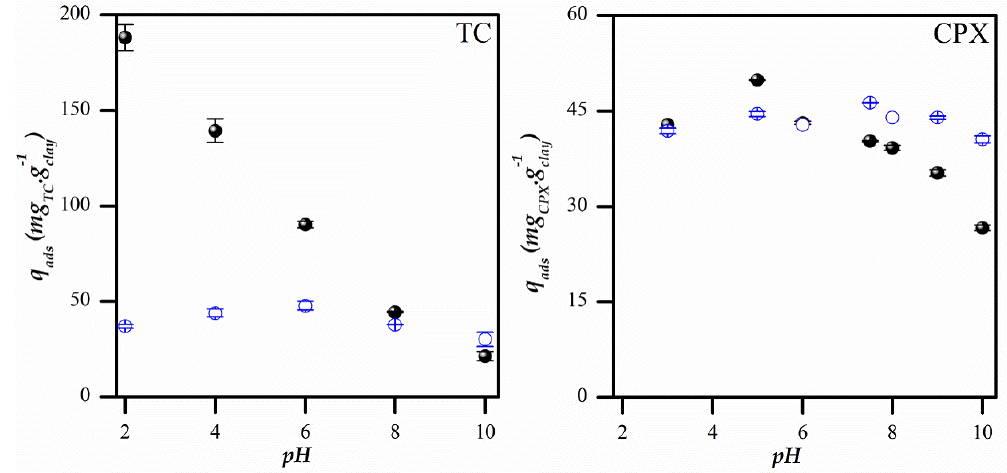
Figure 6. Effect of media pH on CPX and TC adsorption where the full and empty symbols are NC ( ) and Si-PILC 75 ( ), (cid:35)